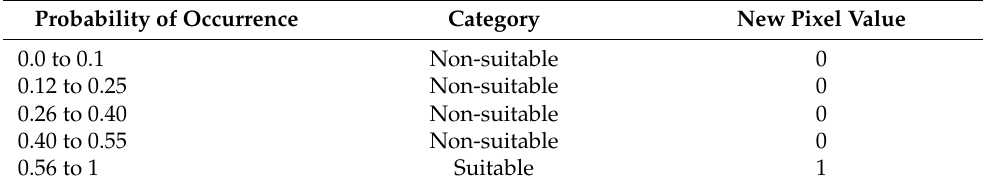
Table 3. Parameters to classify land suitability of Pinus oocarpa trees.